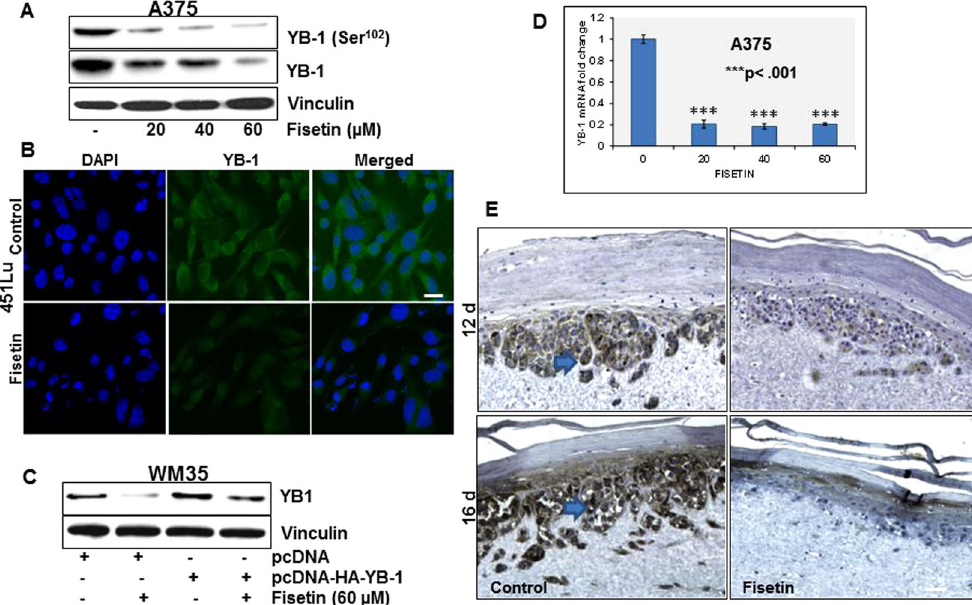
Figure 1. Fisetin inhibits YB-1 in BRAF mutant melanoma cells ( A ) Whole cell lysates of A375 melanoma cells treated with fisetin (20–60 µ M:24 h) were analyzed for p-YB-1 and YB-1 protein expression. Equal loading was confirmed by reprobing for vinculin. ( B ) Representative micrographs (20x) showing immunofluorescence for YB-1 in 451Lu melanoma cells with/without fisetin (60 µ M:24 h). Scale bar, 20 µ m. ( C ) WM35 melanoma cells transfected with pcDNA-HA-YB-1 and treated with fisetin (60 µ M:24 h) were analyzed for YB-1 expression. ( D ) Histogram represents relative YB-1 mRNA levels in fisetin-treated A375 cells (20–60 µ M:24 h) normalized to GAPDH. ( E ) Representative micrographs (10x) showing YB-1 expression in A375 melanoma constructs treated with fisetin (80 µ M), harvested at day 12 and 16 post treatment. Scale bar, 20 µ